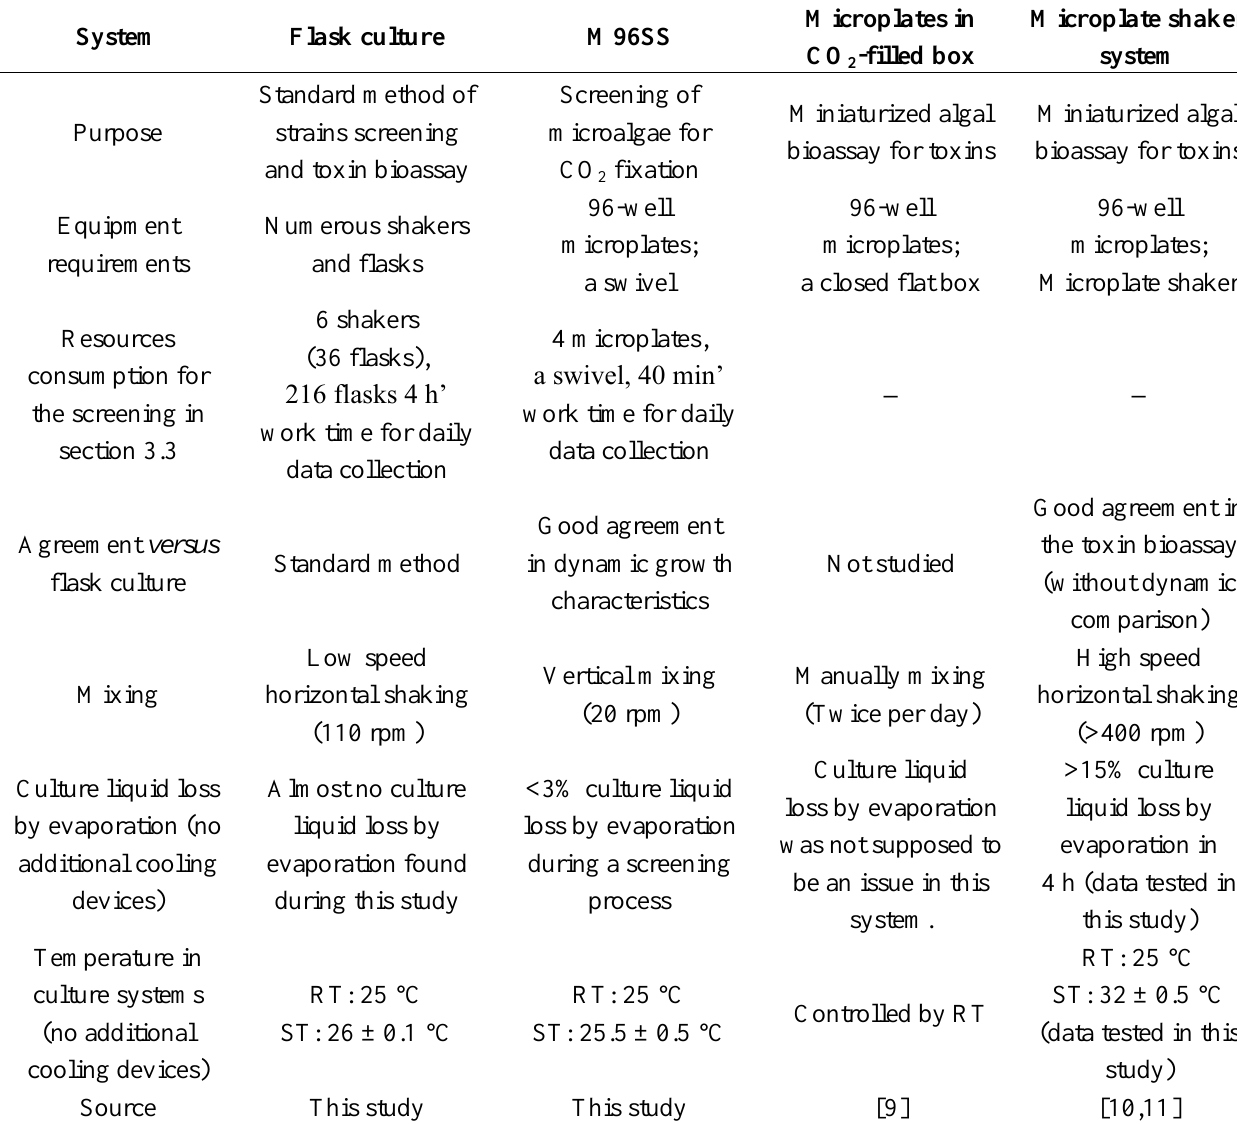
Table 4. Comparison of M96SS and previous screening